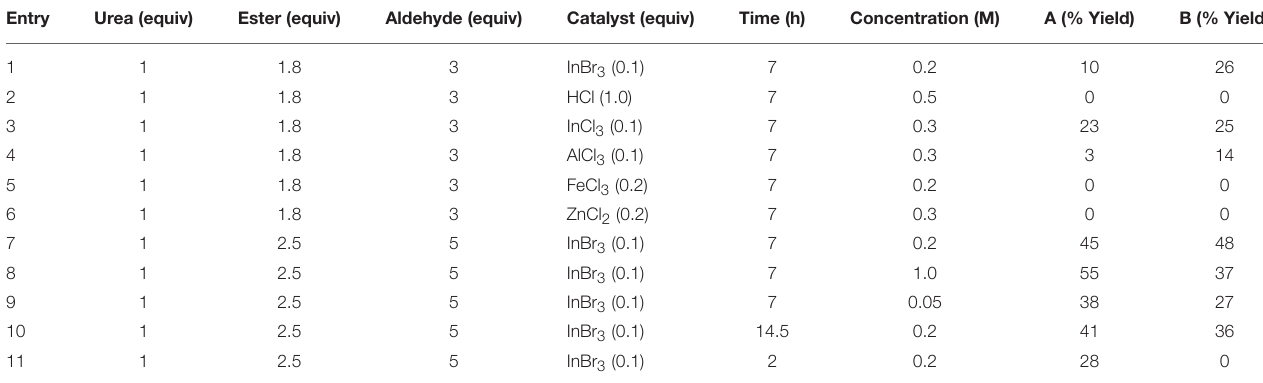
TABLE 1 | Investigation of reaction time, concentration, equivalents, and catalyst with formaldehyde, N,N ′ -dimethylurea, and ethyl acetoacetate ( Figure 3 ). Entry Urea (equiv)